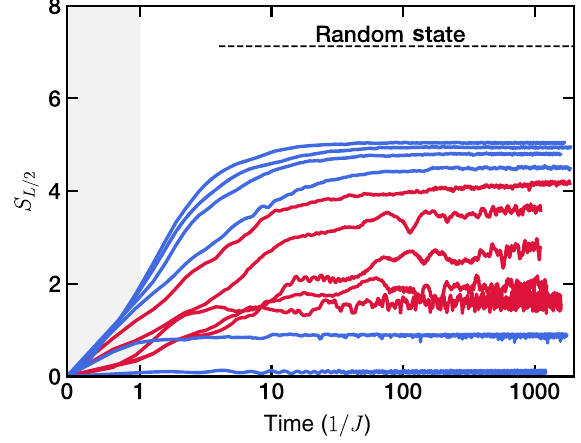
FIG. 9. Evolution of the half-chain entanglement entropy S t Þ for different initial states evolved under the long-range L= 2 ð D . We observe that, for states away from the phase transition (blue lines), the evolution is characterized by a fast approach to a well-defined constant plateau. However, for initial states near the phase transition (red lines), the approach takes a very long time, displaying a slowly growing entropy for very long times and displaying large fluctuations. The initial states, marked in red, correspond to the state lying in the transition region in Fig. 4 of the main